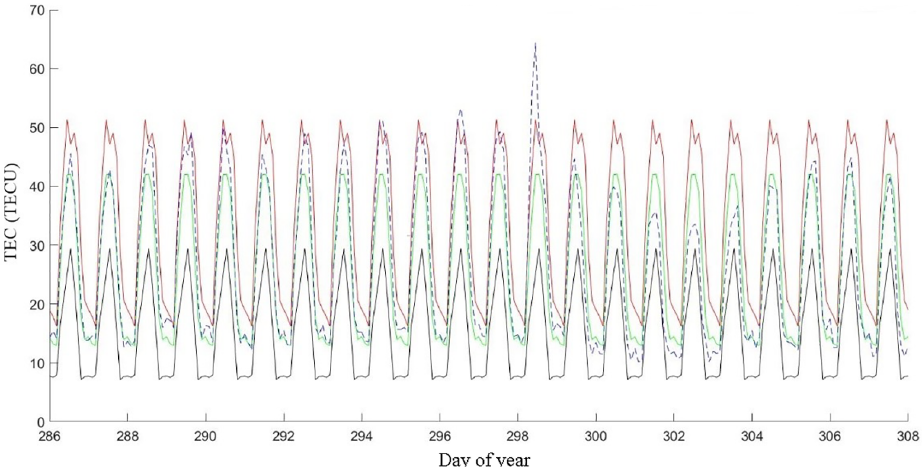
Figure 5. GIM-TEC values for IZMI Station. The black line shows lower bound TEC values, the red line demonstrates upper bound TEC values, the green line shows mean TEC values and the dotted line indicates observed TEC values for every